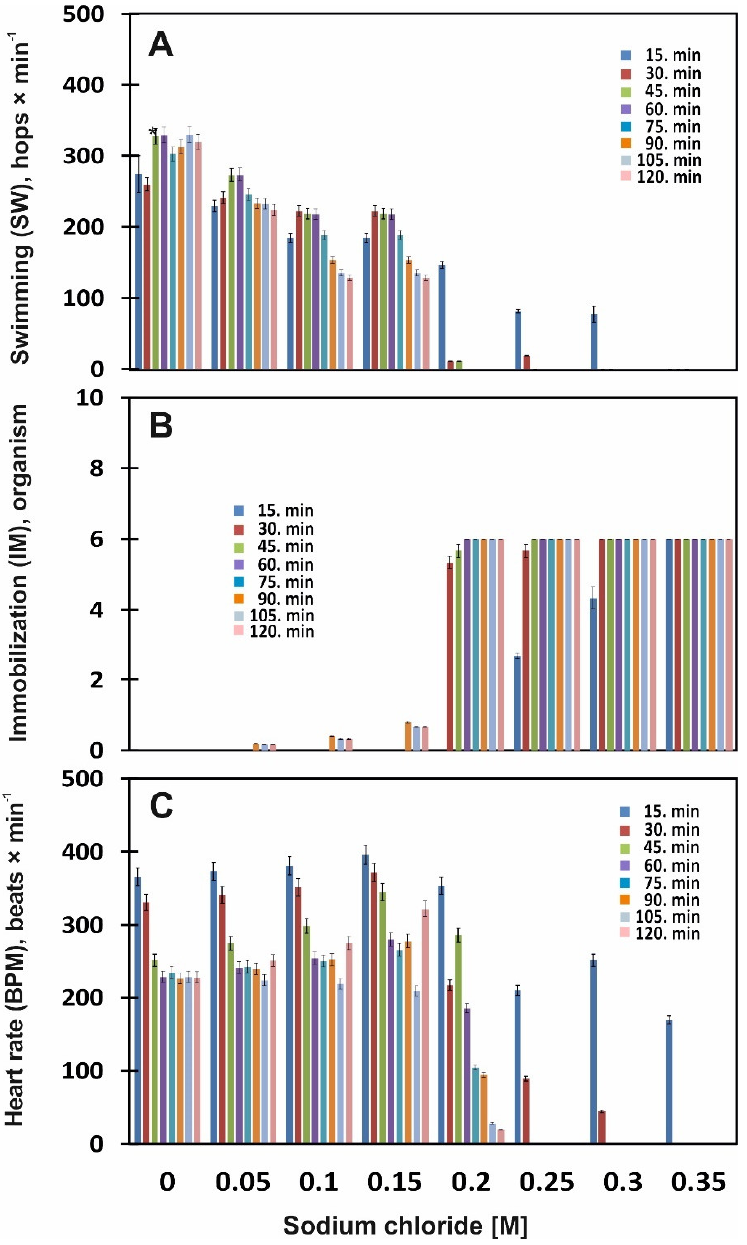
Figure 2. ( A )—Swimming (SW), ( B )—immobilisation (IM) and ( C )—heart rate (BPM) of crustaceans ( Daphnia magna ) exposed to sodium chloride (NaCl) concentrations (0–0.35 M). Data points represent the mean ± SD, n = 6. Only a NaCl concentration of 0.07 M reduced SW by 20% (15 min EC 20 ) after 15 min, while a slightly higher concentration of 0.10 M reduced SW by 50% (120 min EC 50 ) after 120 min (Table 7). An abrupt inhibition of SW was noted at a concentration of 0.2 M after 30 min. In this sample, only 11 hops × min − 1 were noted, as compared to 147 hops × min − 1 after 15 min. At a NaCl concentration of 0.35 M (the highest test concentration), only 15 min were sufficient to prevent the crustaceans from SW (Figure